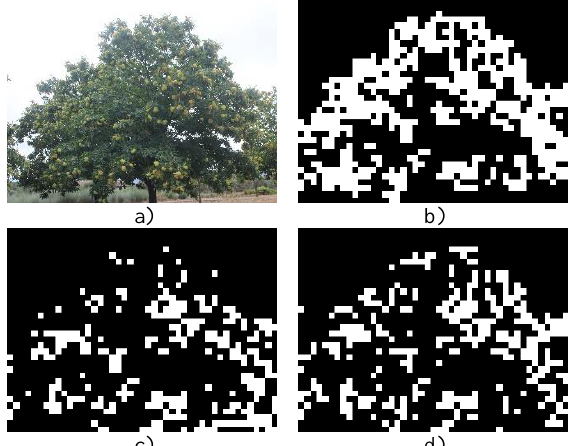
Figure 4. Testing image for assessment purposes: a) is the RGB image of the chestnut used for assessment; b) represents tile-based rough ground-truth; c) is the mask generated by the estimation using a Xception model trained with the non-augmented/unbalanced dataset; d) is the mask generated by the